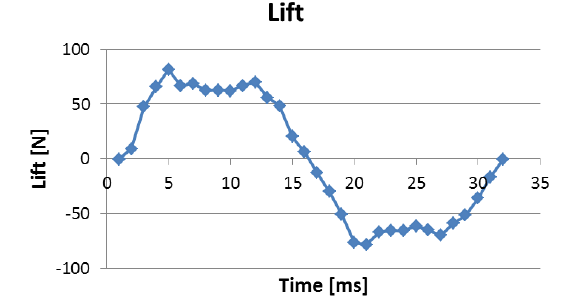
Fig. 5. Plunge-time dependency for M = 0.45 and M = 0.28.